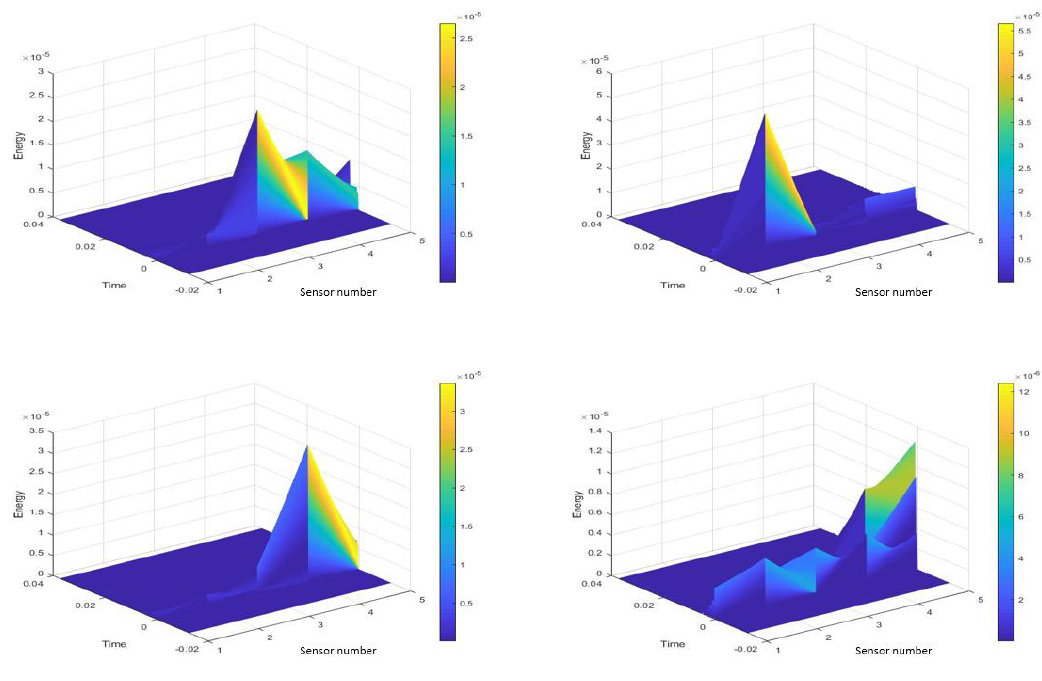
Figure 8. Energy spectrum of sensors 1 to 5 for four different HI’s.